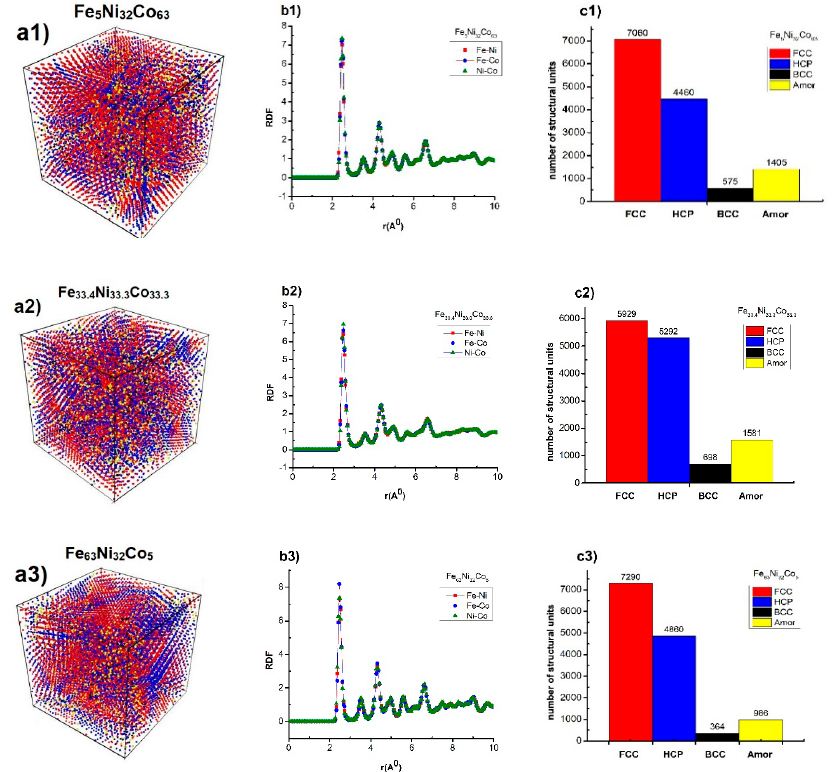
Figure 2. Structure shape ( a1 – a3 ), RDF ( b1 – b3 ), number of the structural unit ( c1 – c3 ) of Fe 1-x-y Ni x Co y alloy at T = 300 K, P = 0 GPa with different adulteration.